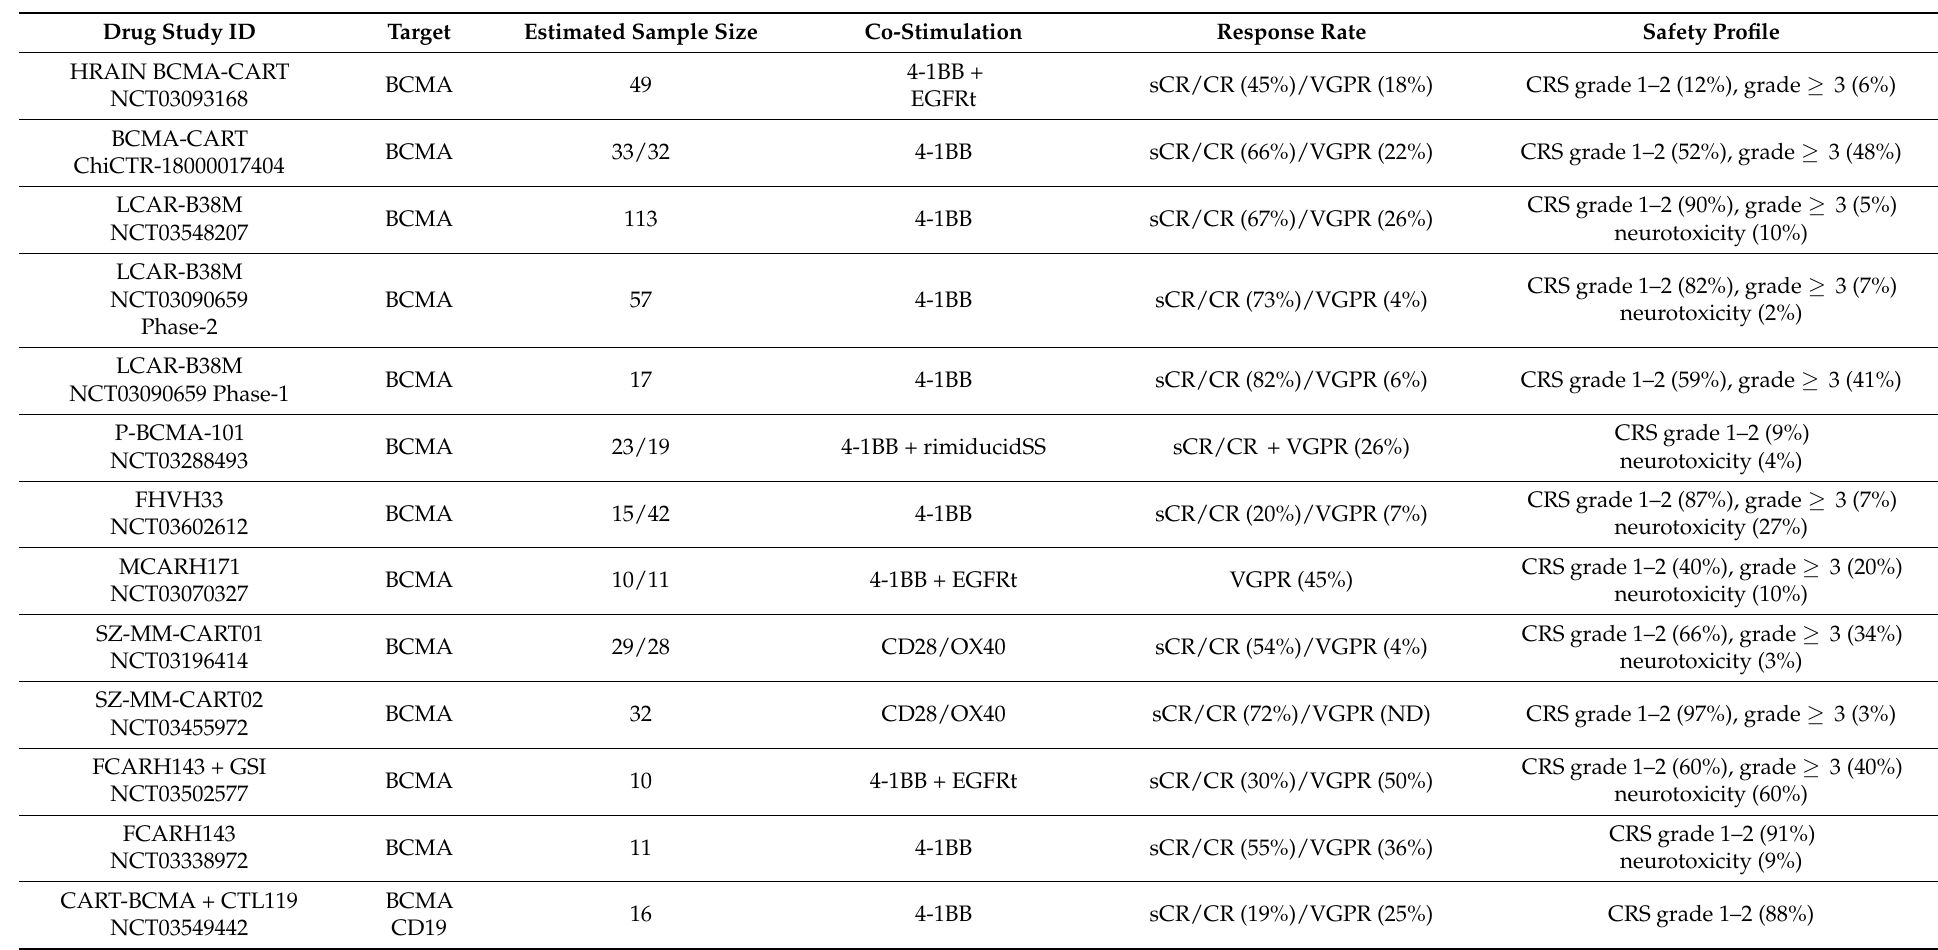
Table 1. Overview of clinical trials with published (interim) results investigating CAR-T cell therapy in multiple